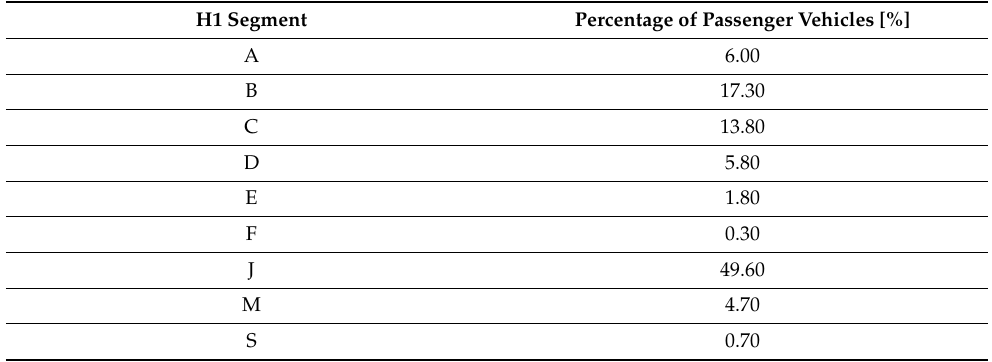
Table 12. Percentage of passenger vehicles belonging to each segment